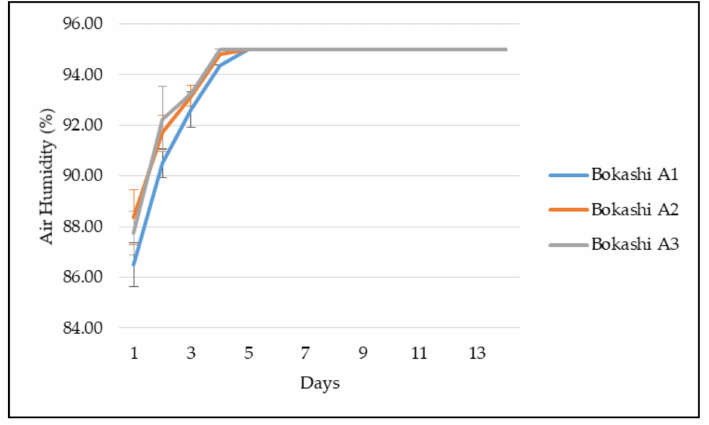
Figure 8. The air humidity observation in the bokashi composting bin of different bokashi types from day 1 to day 14.